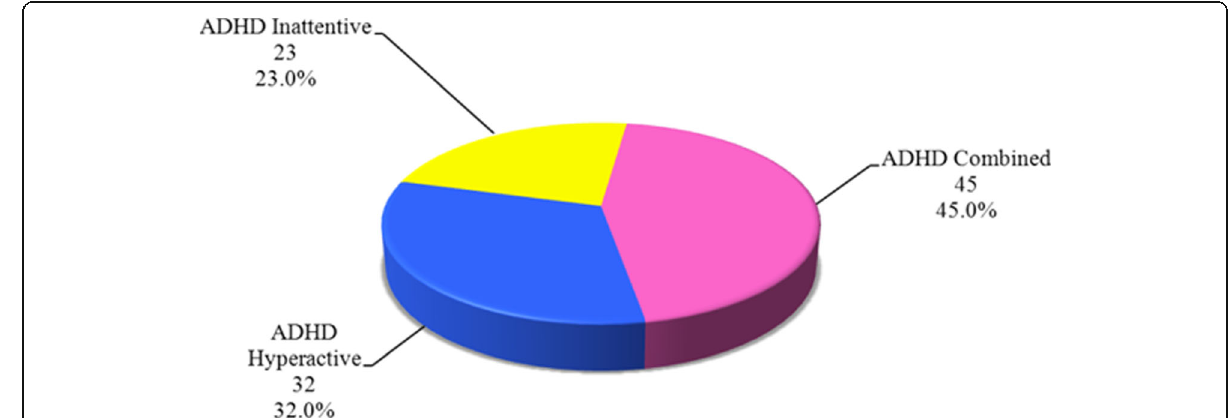
Fig. 1 Distribution of ADHD subtypes in group